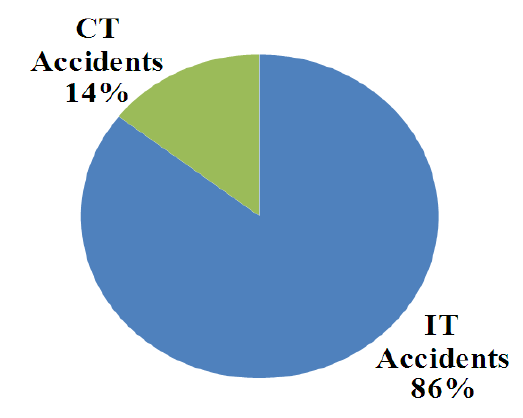
Figure 3. Externality costs by mode of transport, 2008. Key: CT–Collective Transport; IT–Individual Transport. Source: MMA